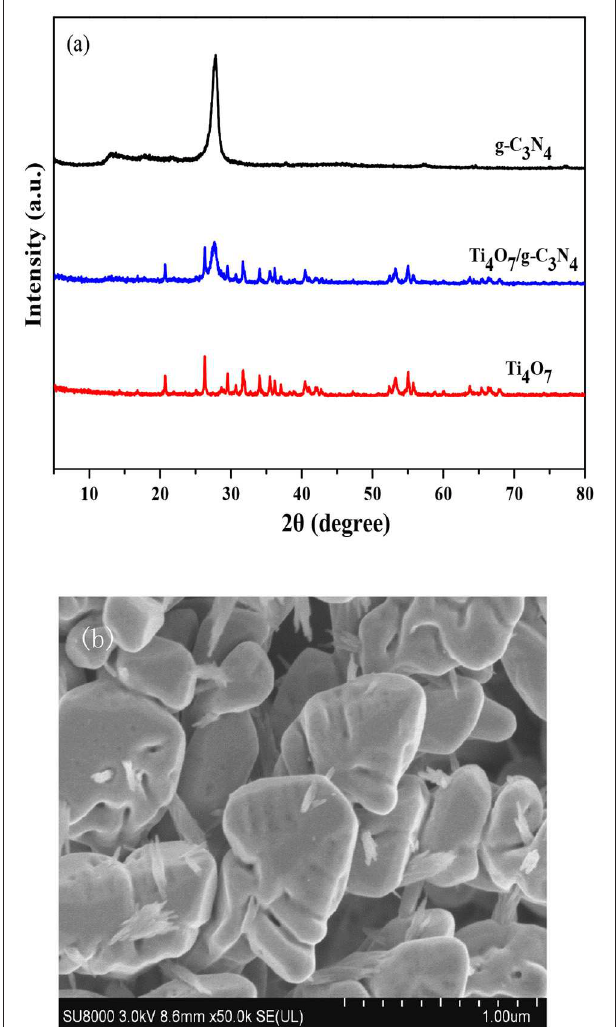
FIGURE 1 | Structure and morphology analyses. (a) XRD patterns of the g-C 3 N 4 , Ti 4 O 7 and 160-Ti 4 O 7 /g-C 3 N 4 photocatalysts; (b) SEM image of the 160-Ti 4 O 7 /g-C 3 N 4